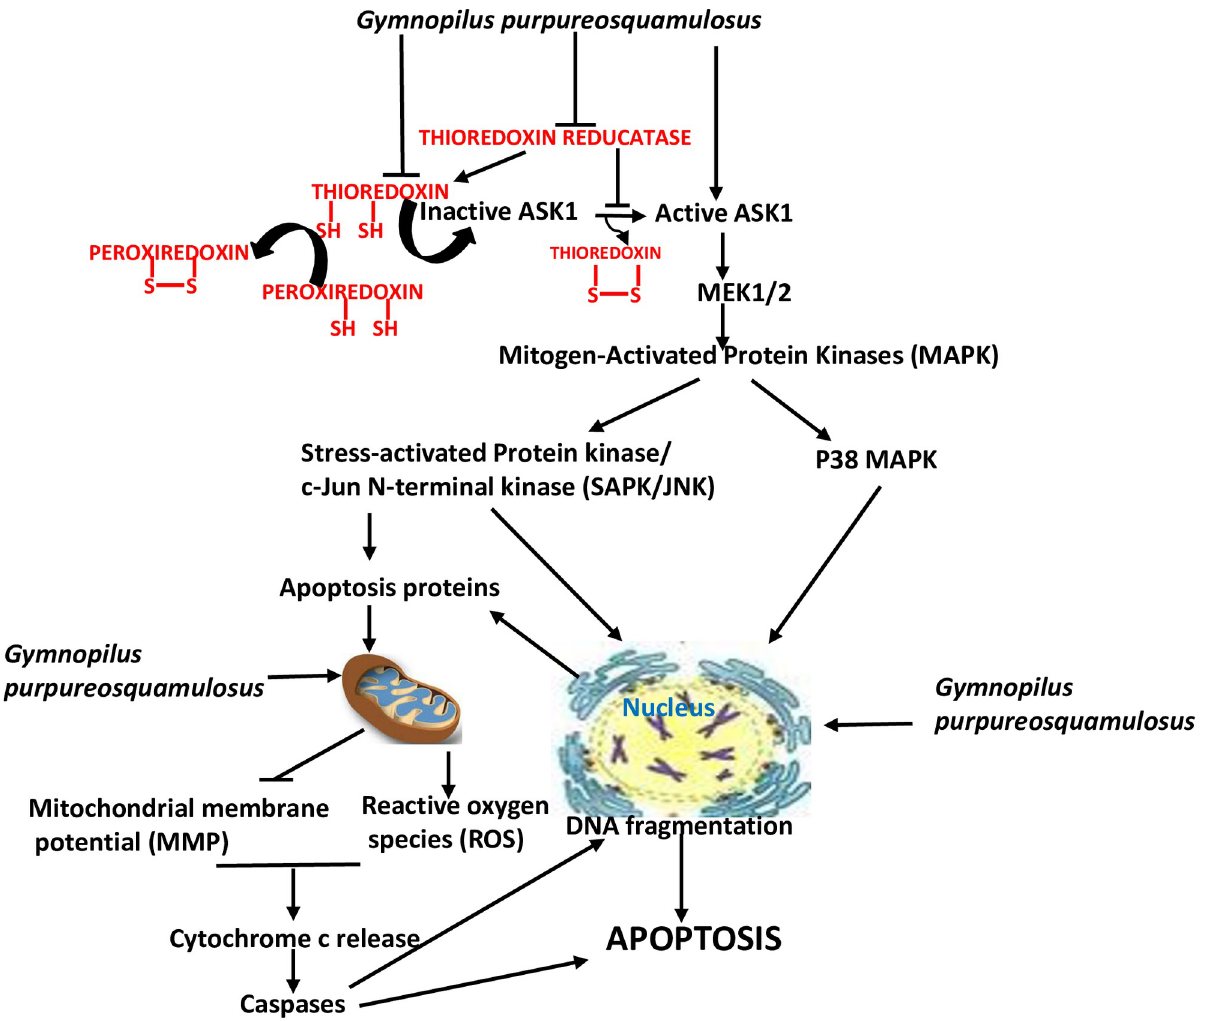
Fig 9. Suggested model for the cytotoxicity of Gymnopilus purpureosquamulosus extract on hematologic malignant cells.